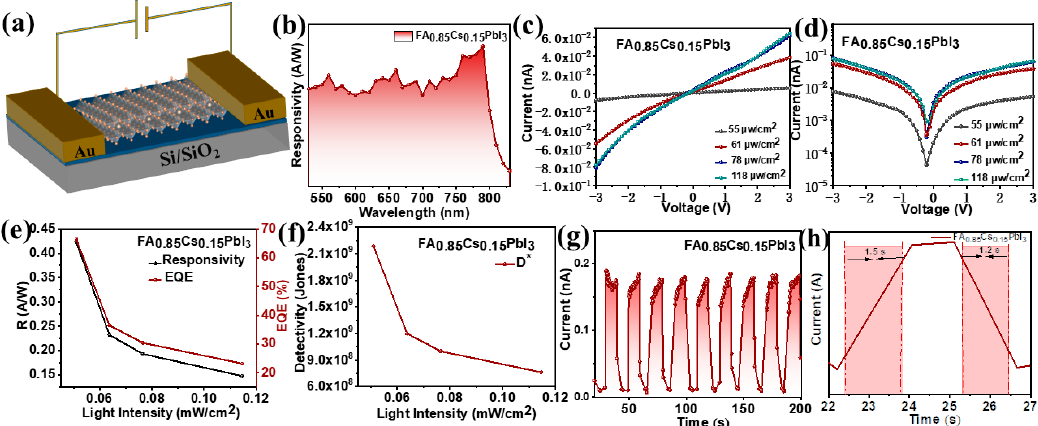
Figure 5 Figure 5. ( a ) Schematic illustration of the FA 1 − x Cs x PbI 3 photodetector; ( b ) spectral responsivity